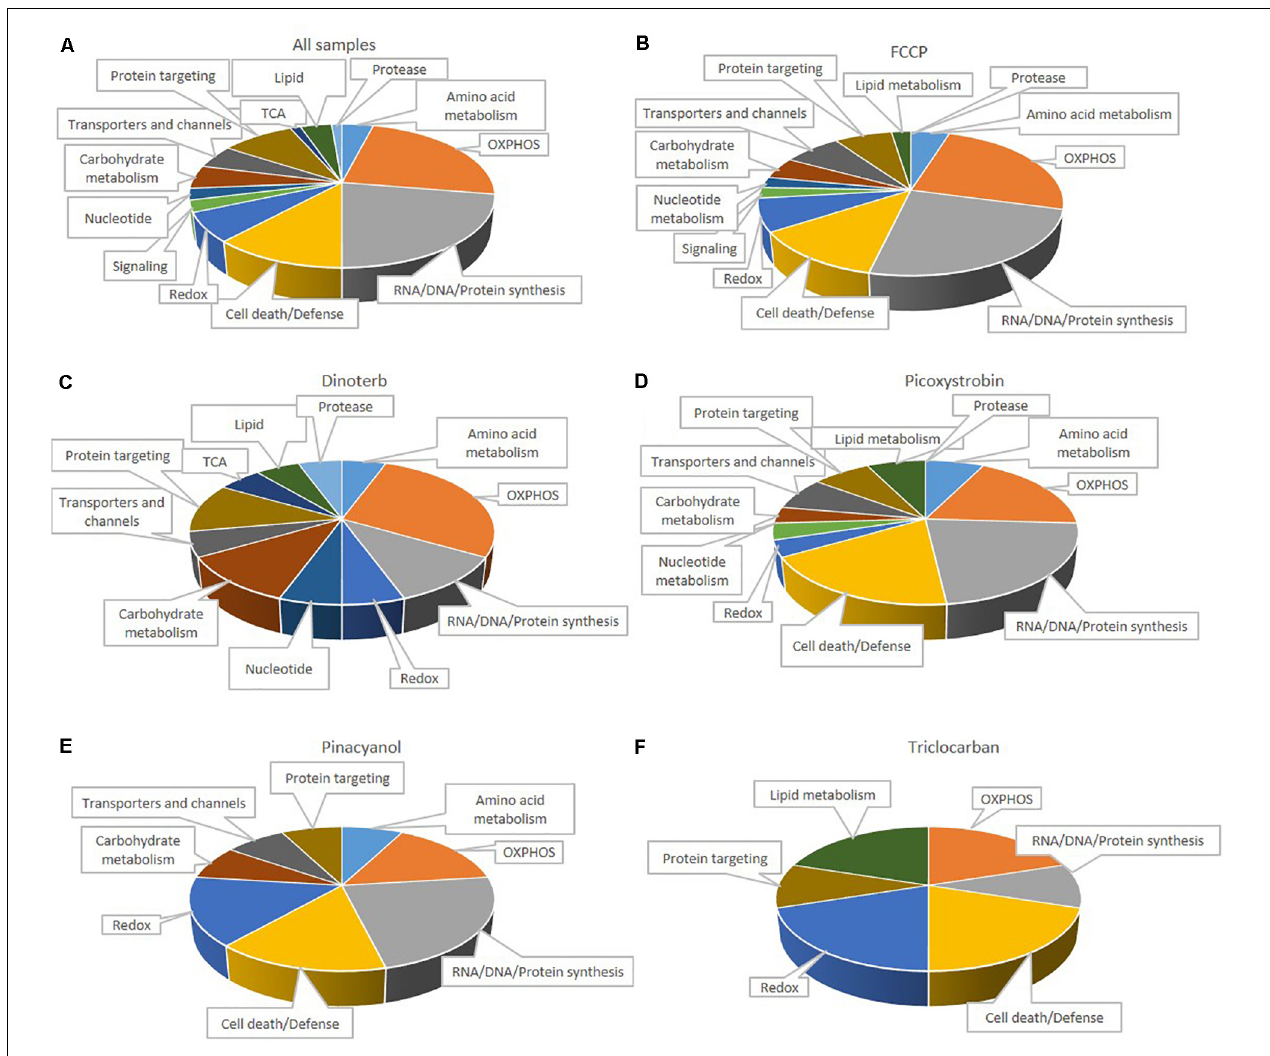
FIGURE 7 | Distribution of 77 functionally classified mitochondria proteins in all samples (A) , FCCP (B) , dinoterb (C) , picoxystrobin (D) , pinacyanol (E) and triclocarban (F) . Assignments were made on the basis of classification of Taylor et al. (2003), KEGG, and information provided in the NCBI nucleotide